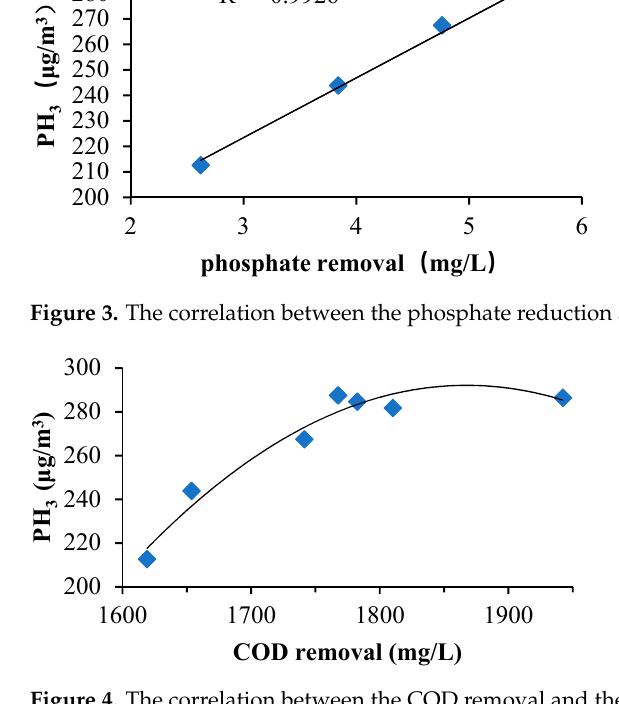
Figure 4. The correlation between the COD removal and the phosphine production.